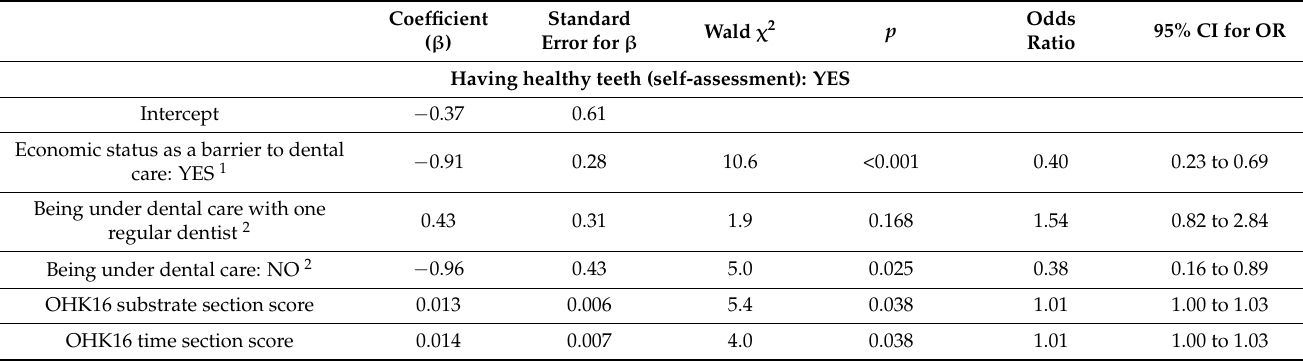
Table 4. Participants’ characteristics vs. selected outcomes (multivariate logistic